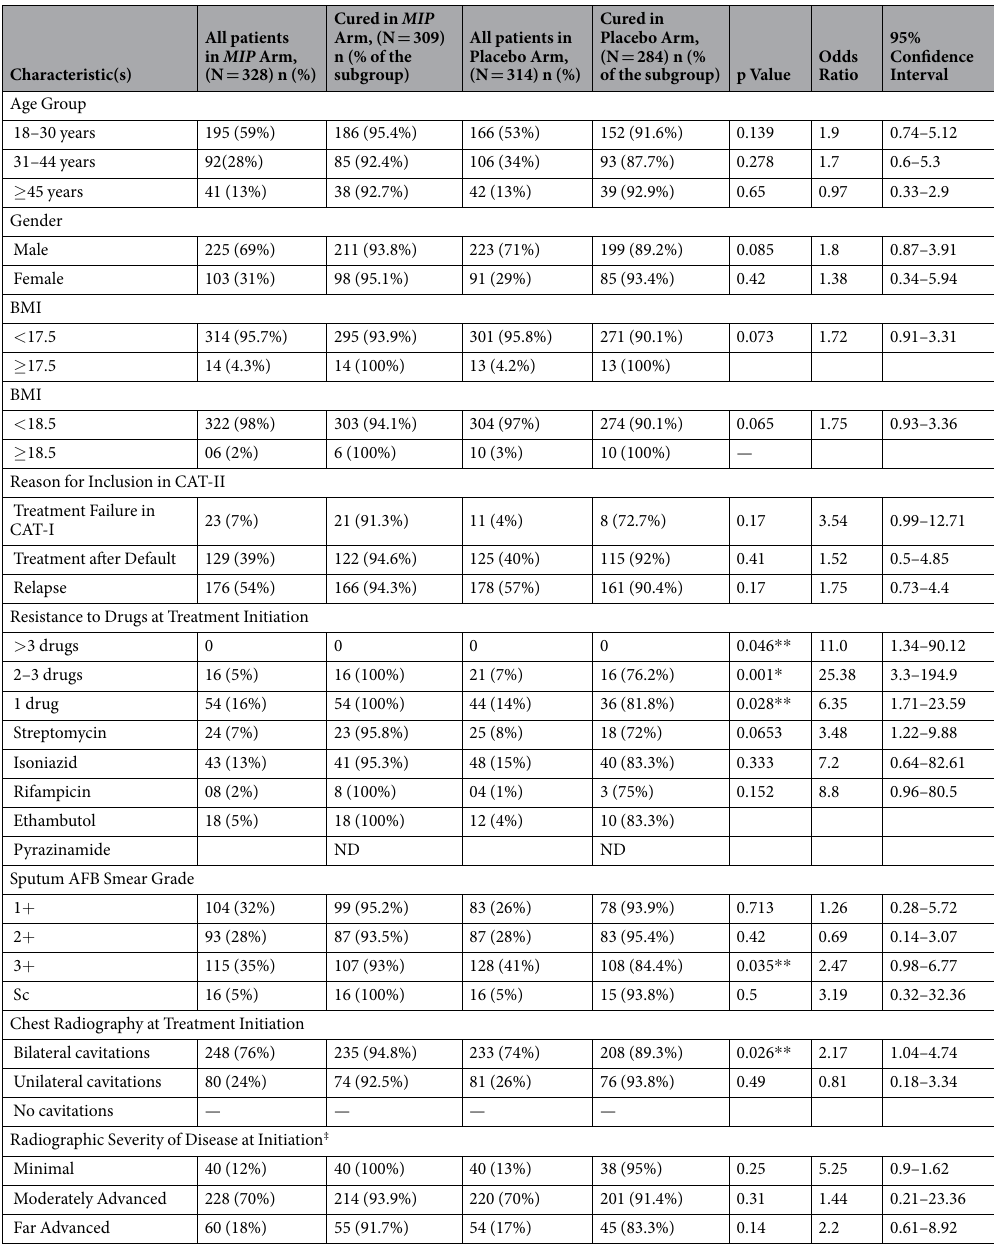
Table 6. Sub group analysis of baseline characteristics of cured patients-Per Protocol (those who completed the treatment). ‡ Radiographic severity at baseline not available for 1 patient; * p value Significant after Boneferroni’s correction. ** Corrected p value not